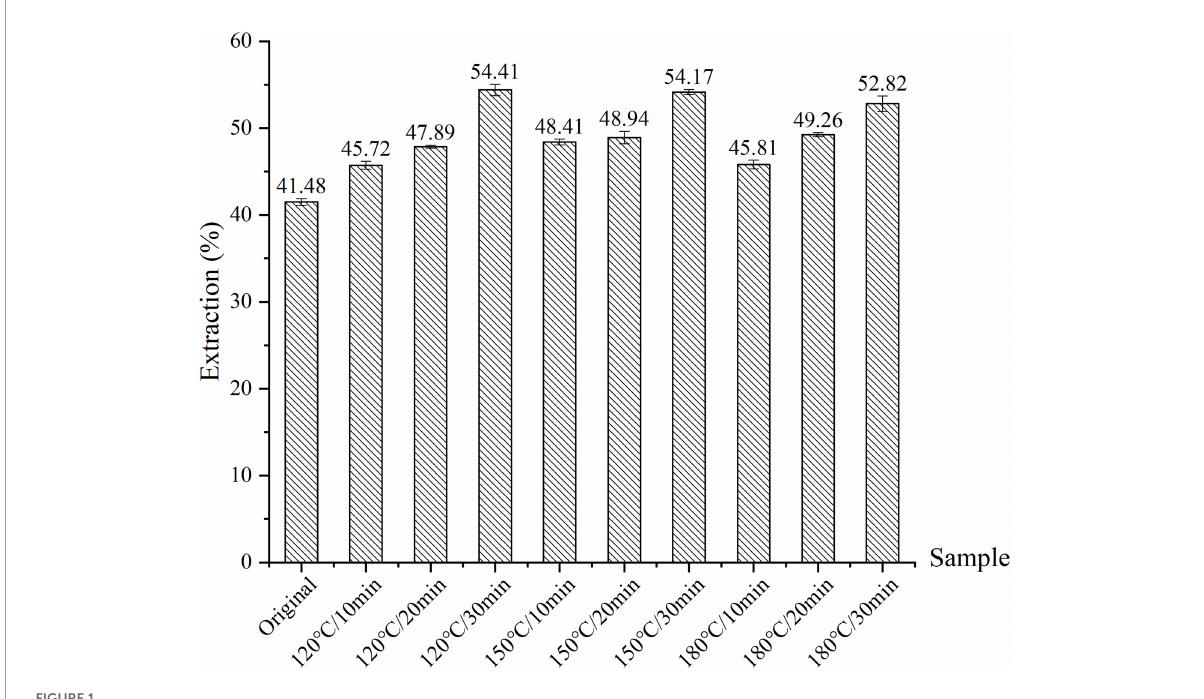
FIGURE1 Extraction yields for walnut kernels roasted with different temperature and duration.